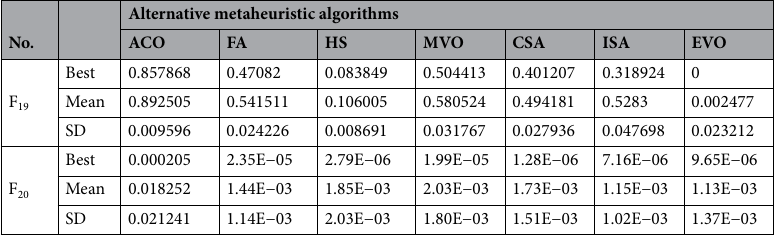
Table 4. The best, mean and standard deviation of different metaheuristics in dealing with mathematical functions.